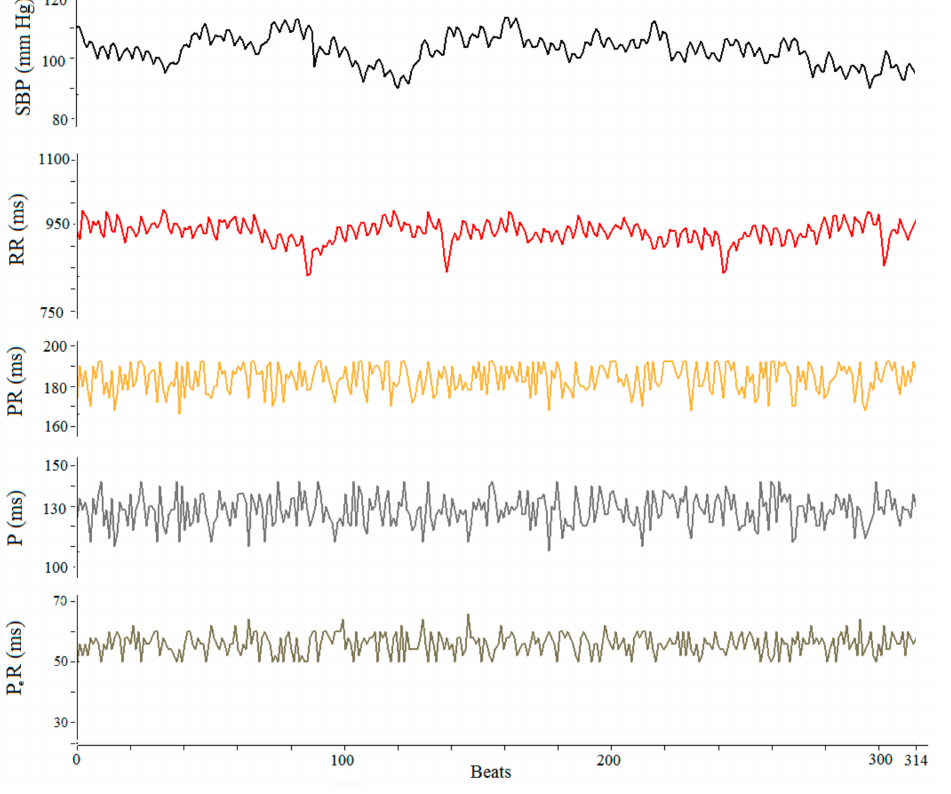
Figure 3. Simultaneous recordings of the study ECG variables (5-min). Note the oscillatory behaviour of every variables (SBP: systolic bold pressure; RR: R-R wave interval; PR: PR interval; P: P wave duration; PeR: P wave end-R wave interval) during controlled breathing (15 breaths per minute).